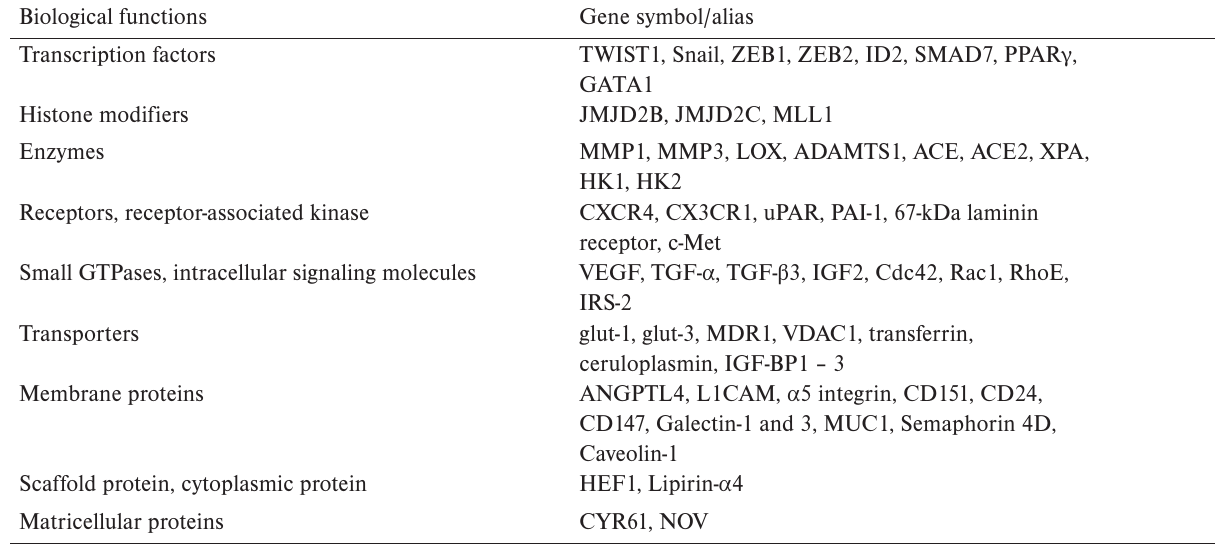
Table 1. Classification of HIF-1 regulated genes (modified according to ref. 42,43 ).